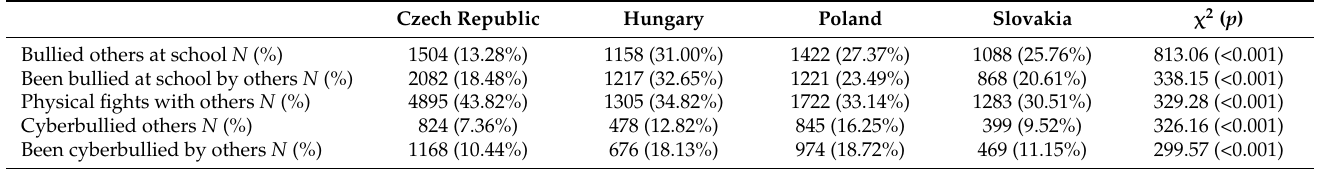
Table 2. Prevalence rates and overall differences in the distributions of peer violence indicated by country.